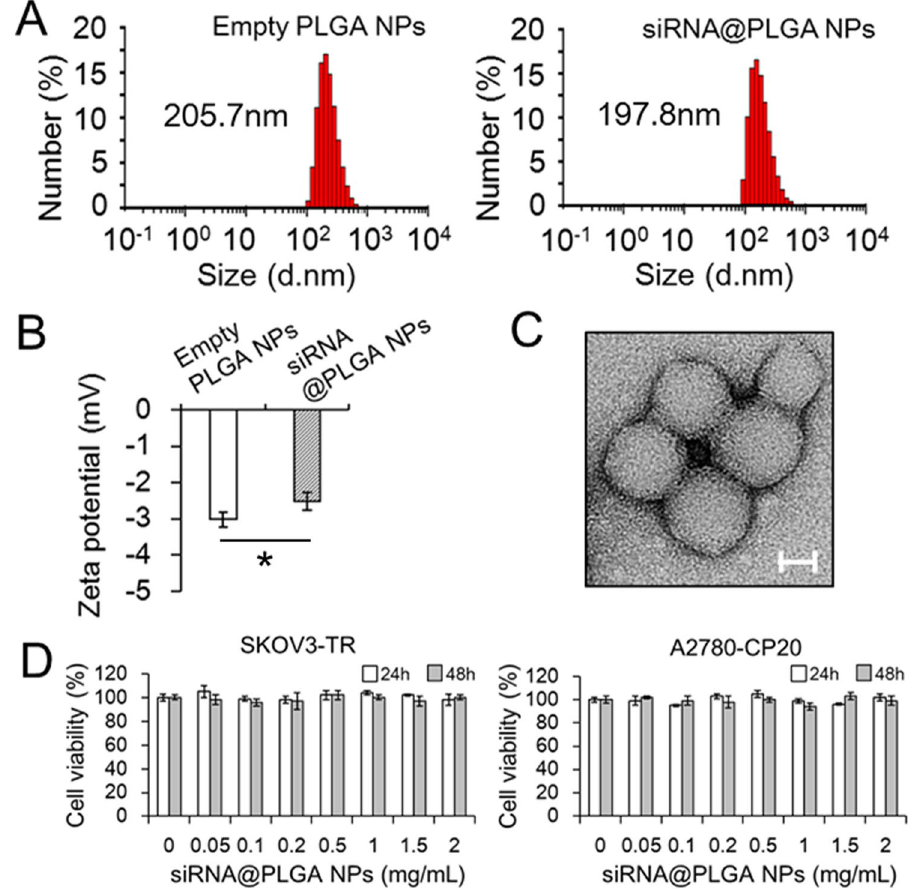
Figure 1. Characterization of siRNA-loaded PLGA nanoparticles. The representative hydrodynamic size distribution profiles ( A ) and zeta potential ( B ) of empty PLGA NPs and PLGA NPs containing MDR1 and BCL2 siRNA (siRNA@PLGA NPs) analyzed on dynamic light scattering (DLS). The negative charge of siRNA@PLGA NPs is slightly lower than that of empty PLGA NPs ( P < 0.005). The results are presented as the mean ± s.d. (n = 3). ( C ) Transmission electron microscopy images of siRNA@PLGA NPs. Scale bar: 100 nm. ( D ) Cytotoxicity studies of siRNA@PLGA nanoparticles on MDR ovarian cancer cells. Cell viability of SKOV3-TR and A2780-CP20 cancer cells treated with incremental concentrations of siRNA@PLGA NPs was determined by an MTT assay for 24 h and 48 h respectively. The results are presented as the mean ± s.d. from three independent